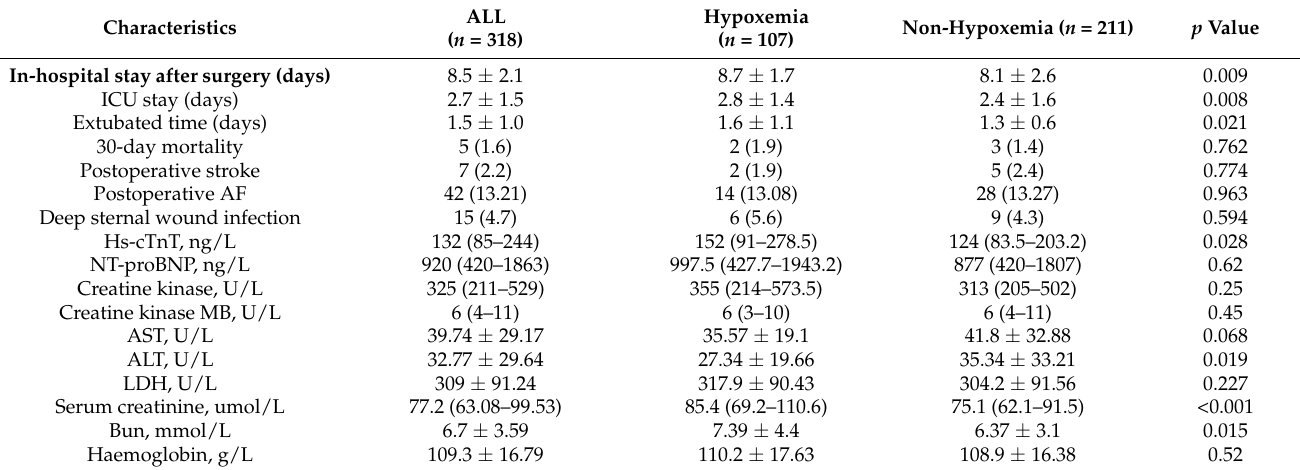
Table 3. Postoperative clinical and laboratory information of patients undergoing OPCAB.